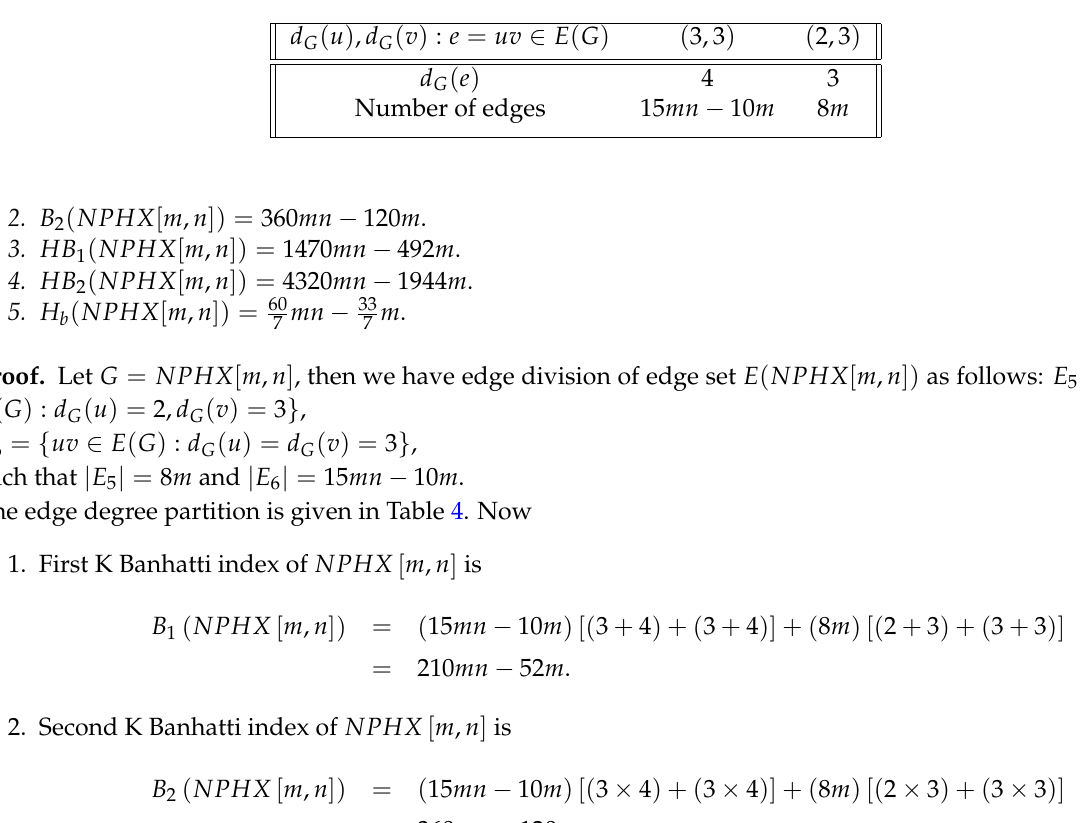
Table 4. Edge Edge degree partition of NPHX [ m , n ]